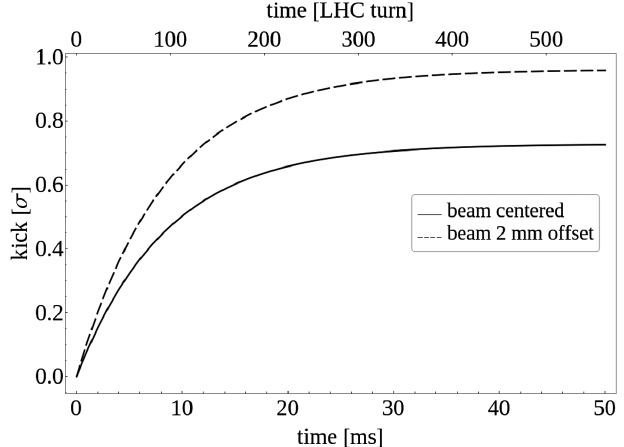
FIG. 20. Kick on beam following a power failure of the wire. The power supply is assumed to be the same type as for Run III.